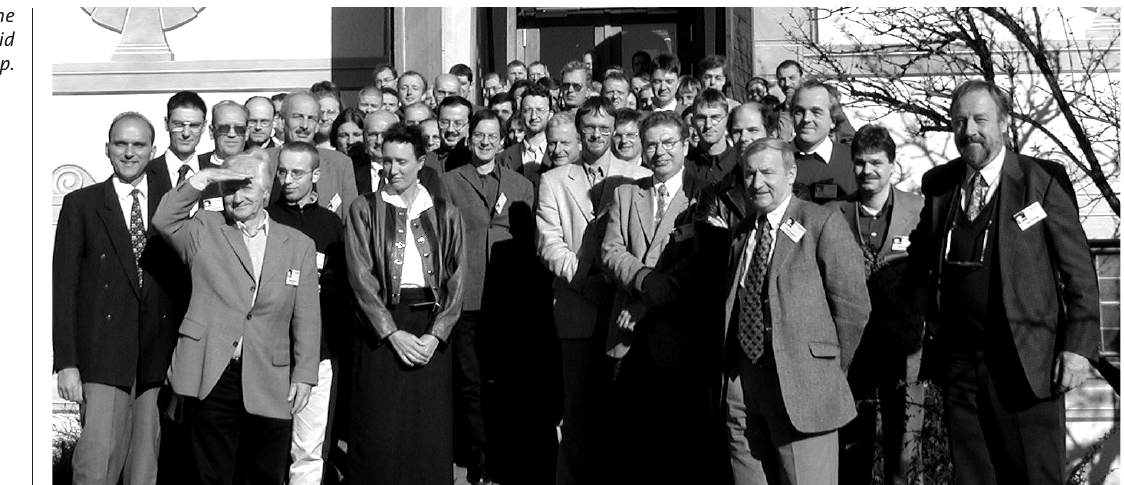
Figure 3: Group foto of the 3rd German Ferrofluid